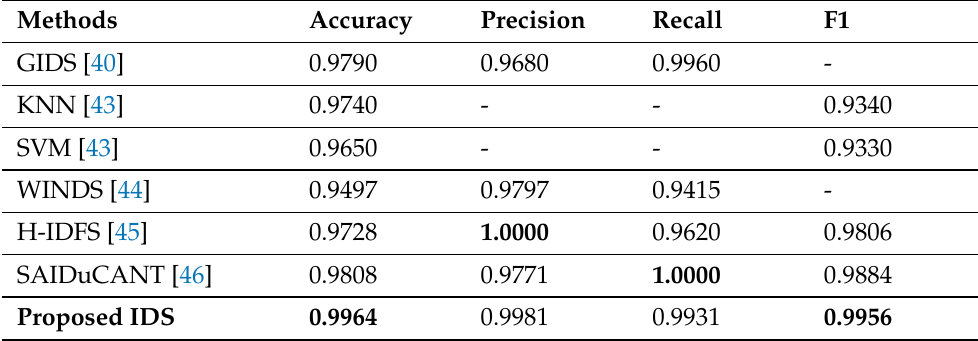
Table 12. Performance analysis against DoS attack for known IDS (car hacking